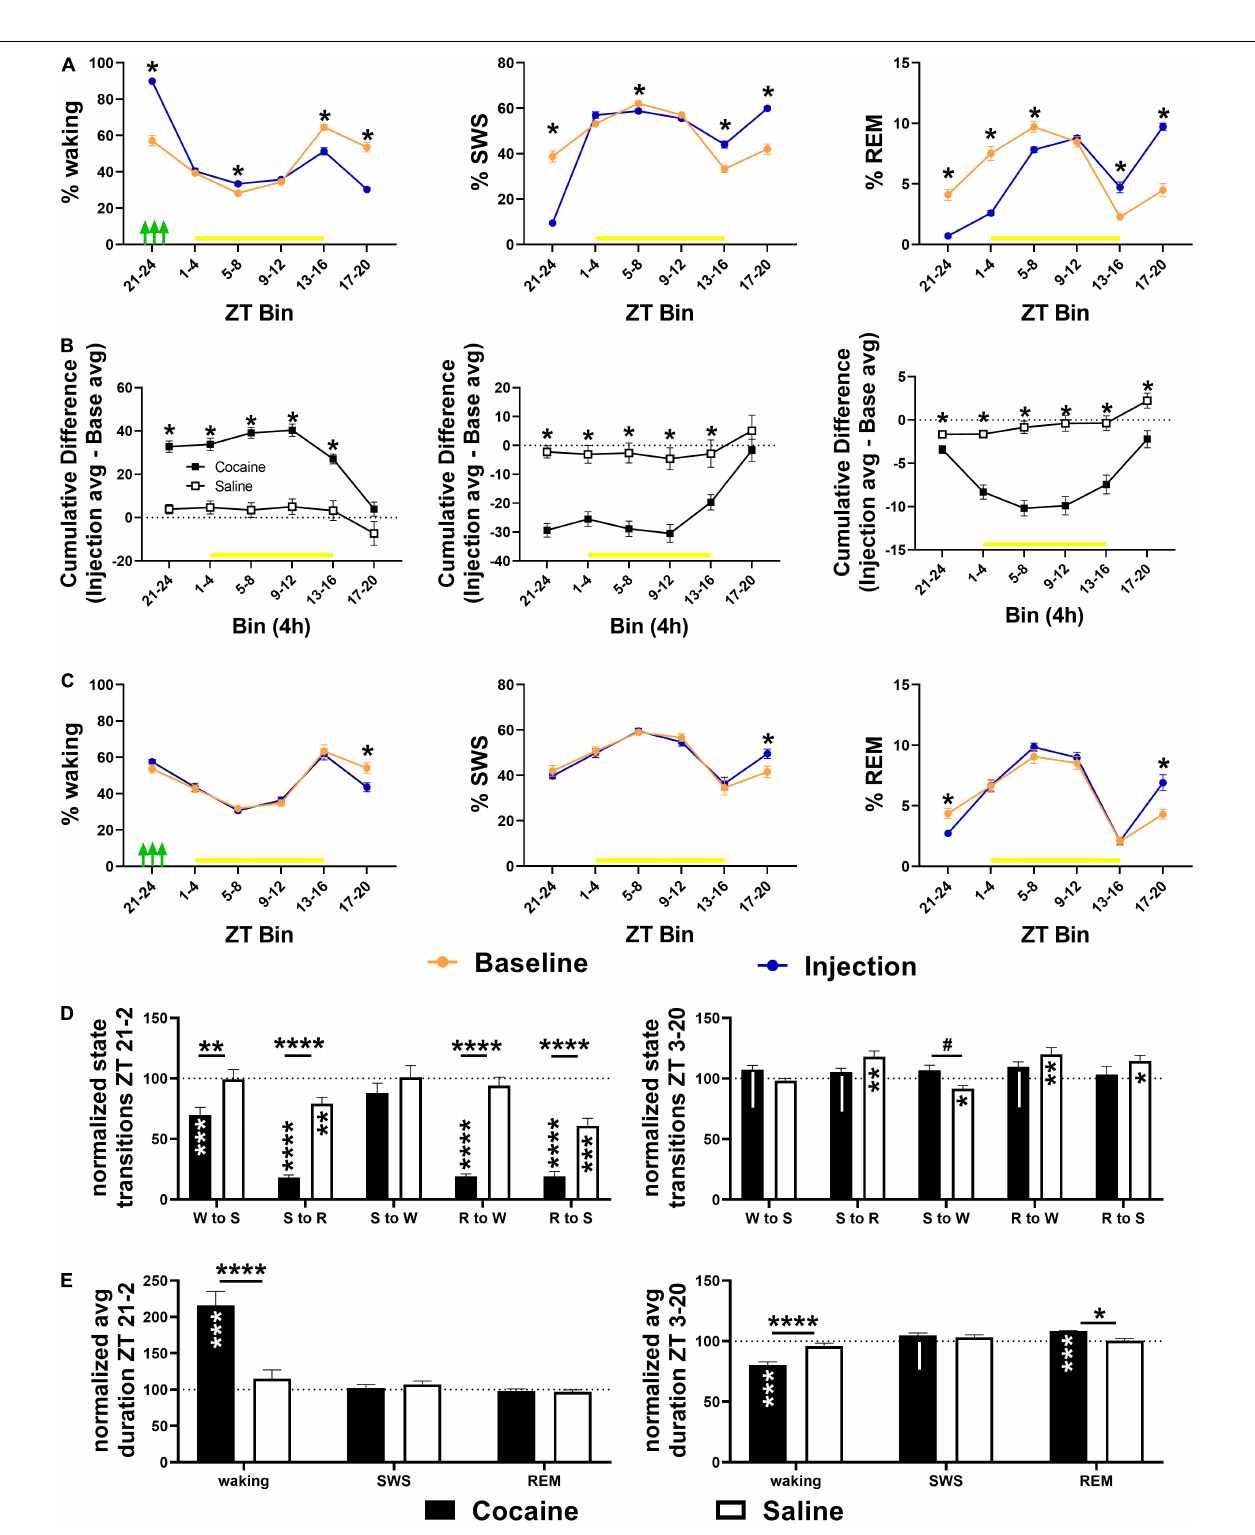
FIGURE 4 | (A) Compared to baseline, cocaine increased waking and decreased SWS and REM during the injection period (indicated by green arrows) followed by a decrease in waking/increase in sleep during the early and middle part of the dark phase with more waking/less SWS during the middle and end of the light phase during the late vs. early injection stage. (B) The cumulative difference between baseline and injection days (Average injection—average baseline) was significantly different between cocaine and saline-treated groups across states, though only the% REM remained significantly different across the 24 h. (C) Compared to